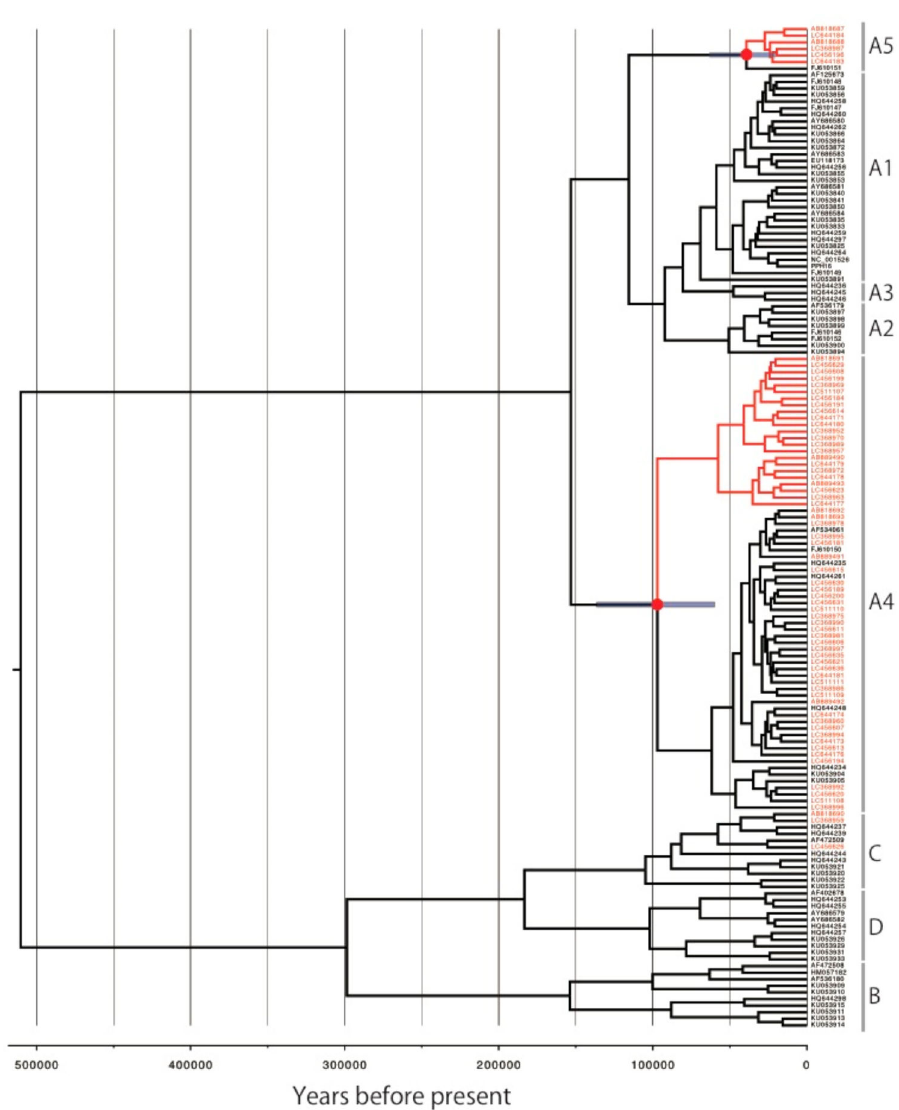
Figure 4. Bayesian MCMC phylogenetic tree of HPV16. The concatenated E6 , E7 , E1 , E2 , L2 and L1 sequences from 152 HPV16 genomes were analyzed in BEAST2. Time-scaled maximum-clade credibility tree is shown. Red node indicates the position of the most recent common ancestor for the Japan-specific HPV16 variants. Blue bar indicates 95% highest posterior density interval. The HPV16 sequence dataset of Pimenoff et al. [16] included seven HPV16 isolates from Japan, which was used to confirm our divergence time estimates. The